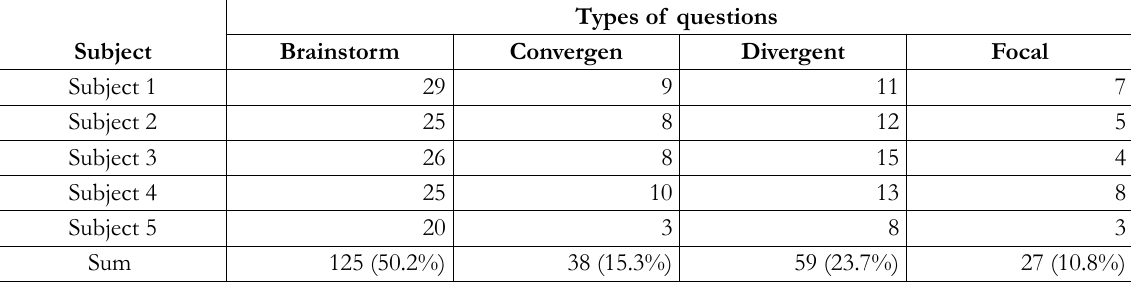
Table 2. Types of questions are asked in learning